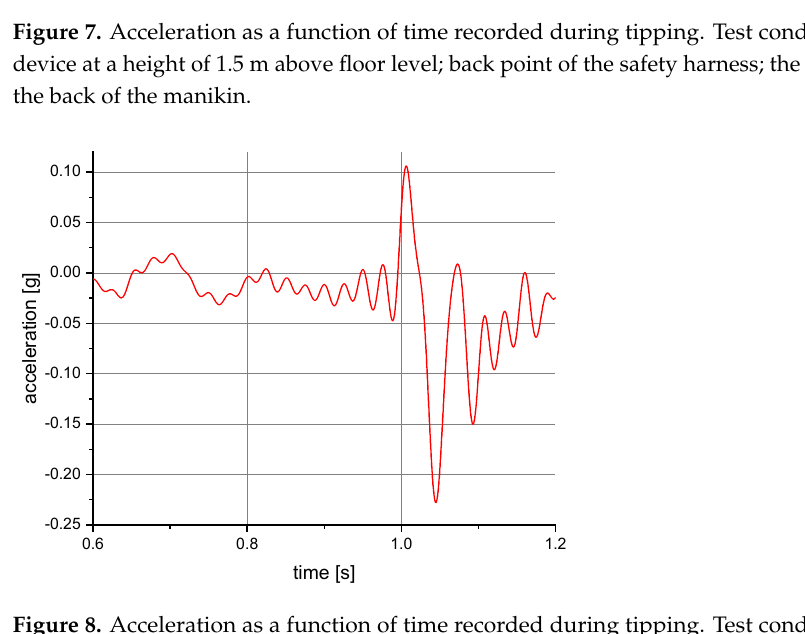
Figure 8. Acceleration as a function of time recorded during tipping. Test conditions: self-locking device at a level of 1.5 m above floor level; front point of the safety harness; the sensor mounted on the abdomen of the manikin.